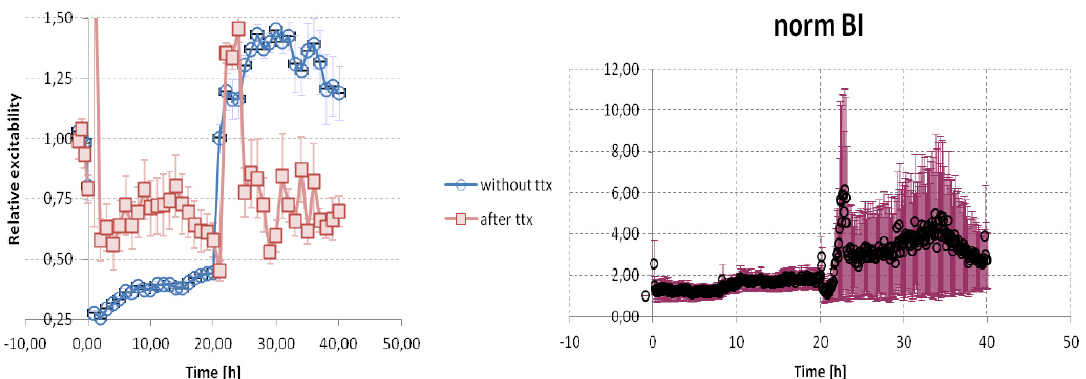
Figure 9. The same as in Figure 8 for two additional parameters descriing spontaneous neuronal firing in dissociated neocortical cell cultures: left—the estimated overall excitability relative to the pre-carbachol baseline is given by the “Single Pulse Response” parameter (see [90] for details); right—the Burst Index (BI: see [63] shows a strong and prolonged post-carbachol (20–40 h) augmentation in both groups, along with a very large inter-individual variance in the TTX pre-treated